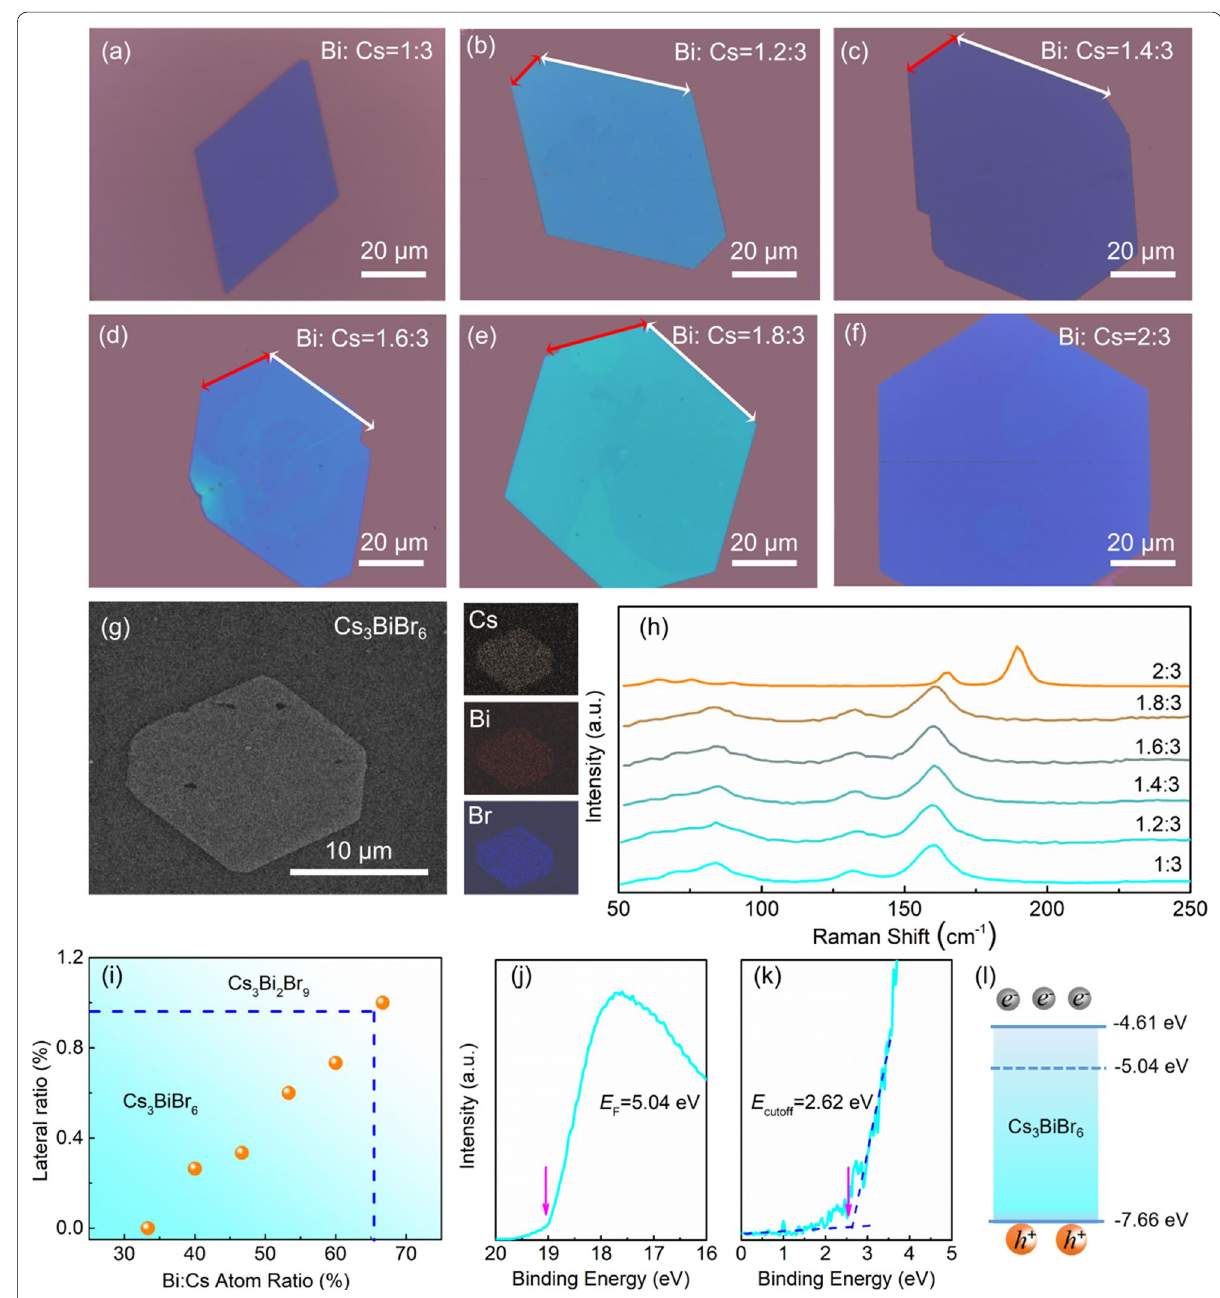
Fig. 3 Optical microscope images of the Cs 3 BiBr 6 film grown with varied Bi: Cs ratio: a 1: 3, b 1.2: 3, c 1.4: 3, d 1.6: 3, e 1.8: 3, f 2: 3, respectively. g EDS mapping of the Cs 3 BiBr 6 film grown with the Bi:Cs ratio of 1.6:3. h Raman spectra of the Cs 3 BiBr 6 film grown with varied Bi:Cs ratios. i Statistical image of film morphology changing with Bi:Cs ratios, the different colors in the figure represents Cs 3 BiBr 6 and Cs 3 Bi 2 Br 9 phases region, respectively. j , k UPS patterns of the Cs 3 BiBr 6 film. l Schematic band structure diagram of the Cs 3 BiBr 6